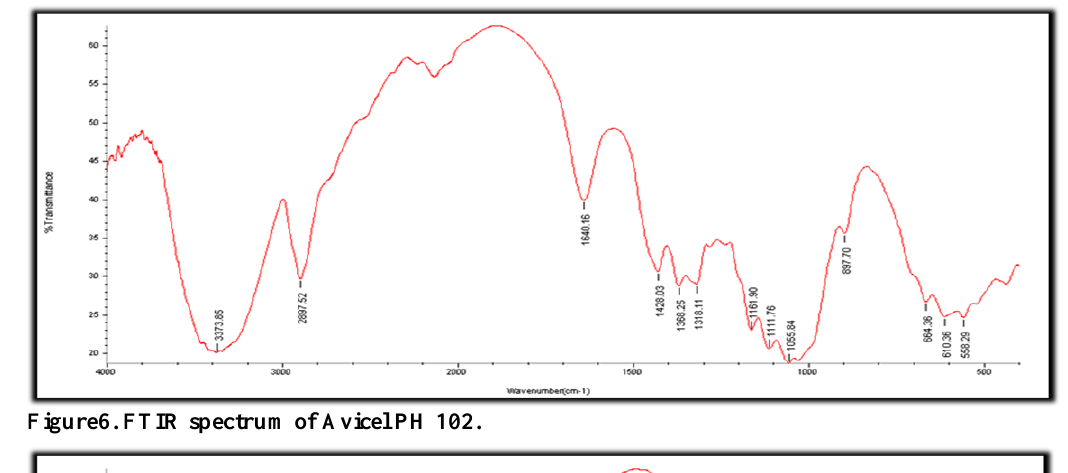
Figure6. FTIR spectrum of Avicel PH 102.